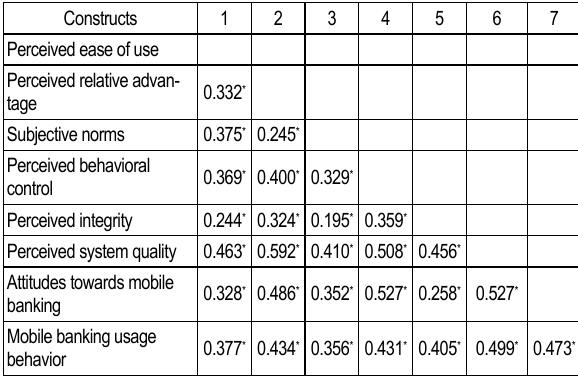
Table 3. Correlation